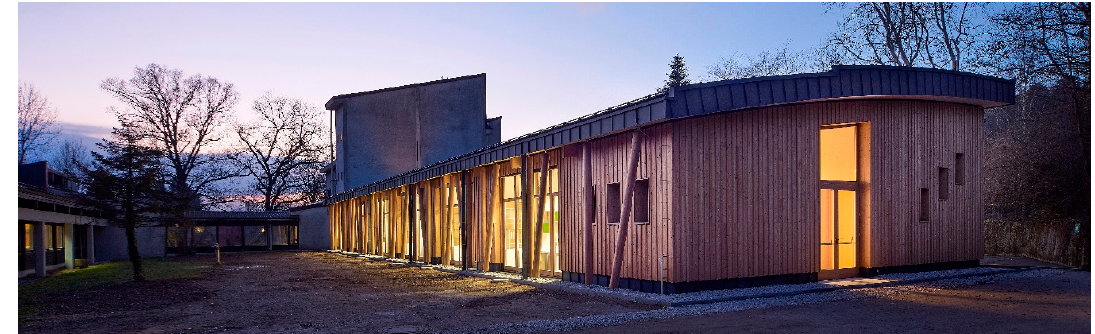
Figure 1. Annex to the existing building of the Department of Wood Science and Technology in Ljubljana (photo: Damjan Švarc).